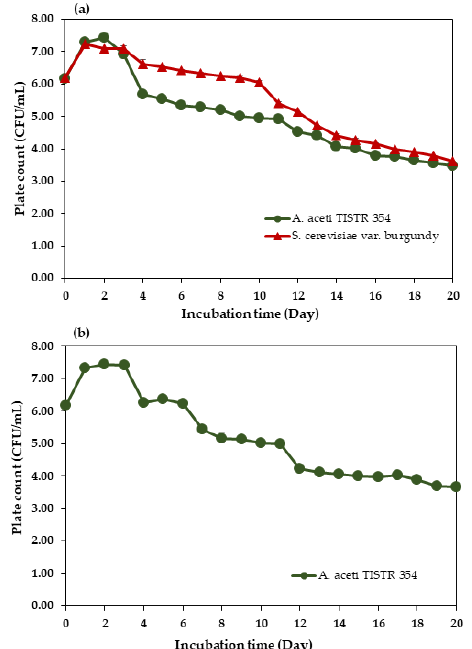
Figure 3. Change in microbial populations of fruit vinegar in one-step fermentation ( a ) and sequential fermentation ( b ).